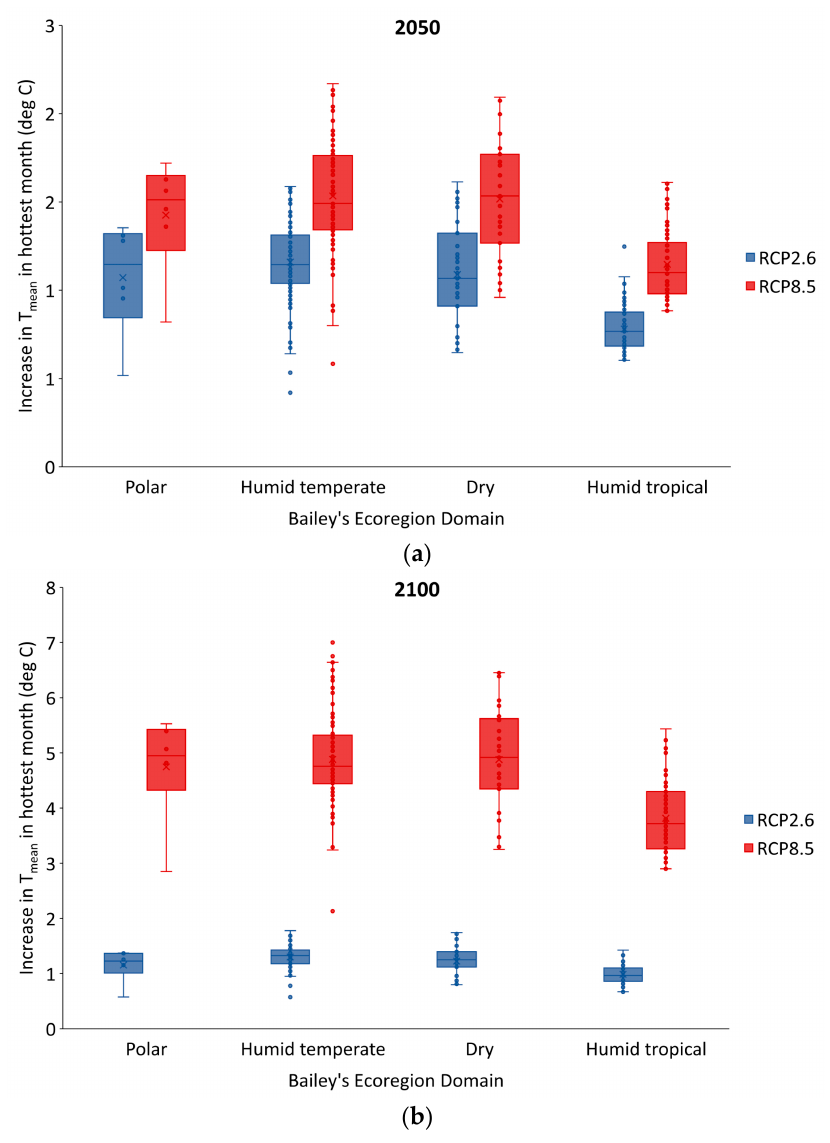
Figure 4. Increases in T mean in the hottest month under RCP2.6 (blue) and RCP8.5 (red) relative to 2017 for cities in different Bailey’s ecoregion domains by: ( a ) the year 2050 and ( b ) the year 2100.